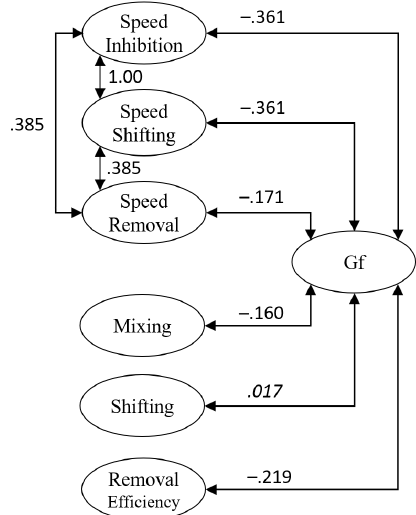
Figure 3. Illustrations of the relationships between domain-general factors from the executive processing tasks with the domain-general Gf factor extracted from Gf measures. Parameters in italics did not differ significantly from